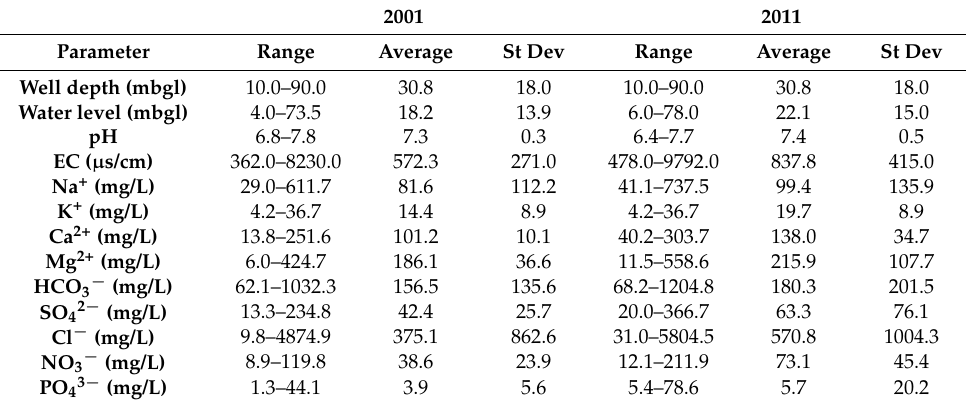
Table 2. Statistical summary of water quality for the years 2001 and